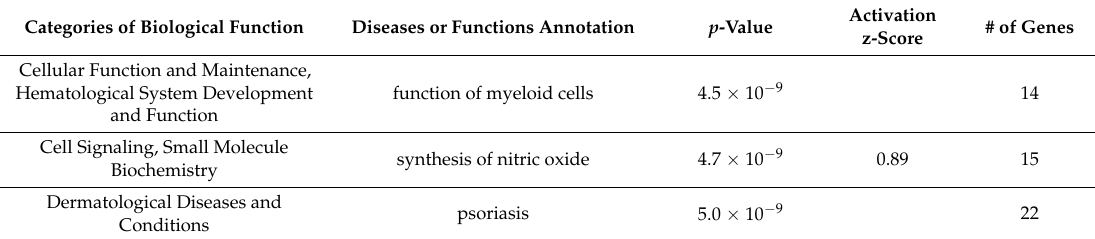
Table 7. Categories of biological functions with diseases or function annotation activated